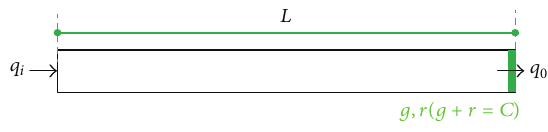
Figure 2: A Single one-way